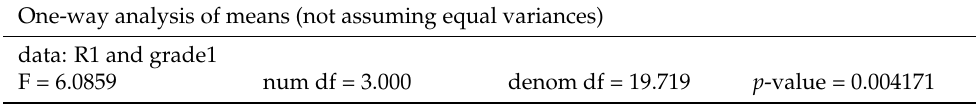
Table 14. One-way analysis of mean (not assuming equal variances) for DETAX material. One-way analysis of means (not assuming equal variances) data: R2 and grade2